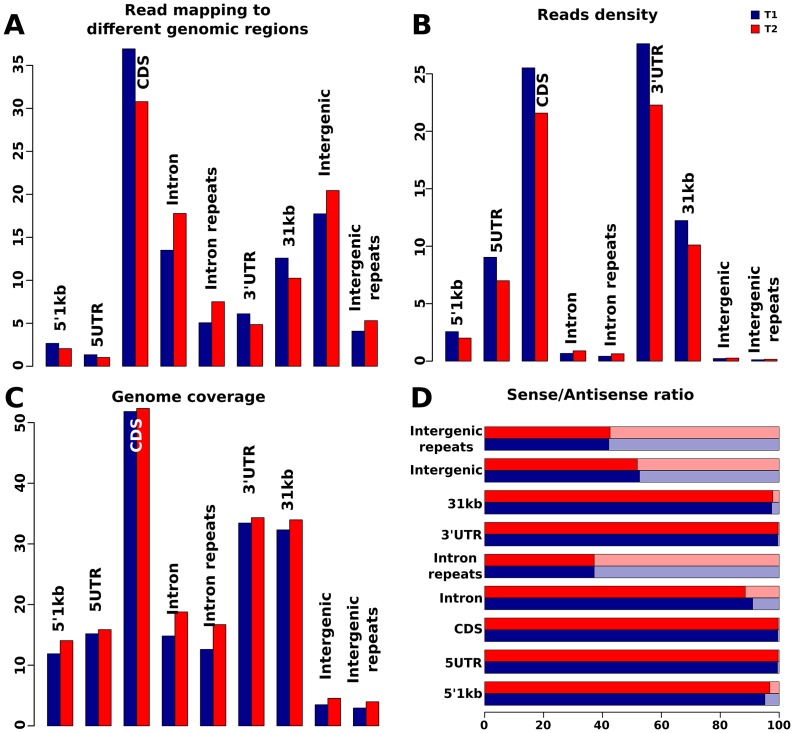
(A) Basal (T1) and race (T2) sample reads map to different genomic regions.The majority of the reads map to known genes (CDS, 3′ UTR and 5′ UTR), while a large fraction maps to non-coding regions (introns, intergenic regions, and the 1-kb regions up- and downstream of genes). Comparison between T1 and T2 show a transcriptional shift from coding to non-coding predicted regions. (B) Expression density was calculated as number of reads normalized by the lengths of each genomic region. (C) Fraction of bases covered in the different genomic regions. (D) Fraction of reads that map to the sense (light) and antisense (dark) strands in each genomic region. In the intergenic region, the fraction was calculated using the number of reads from the plus and minus strands.